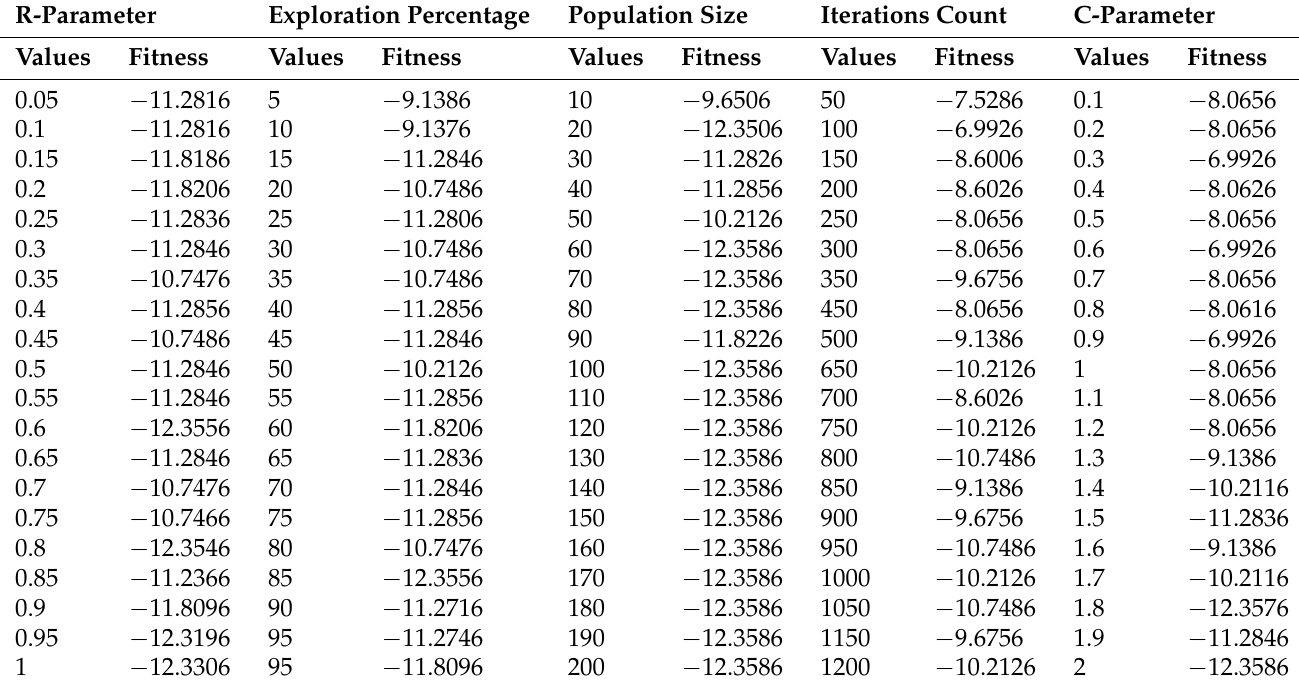
Table 16. Minimum Fitness results for different values of the GSDTO’s